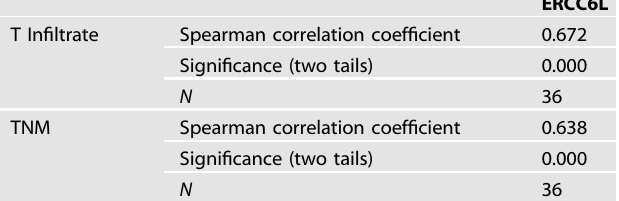
Table 3. Relationship between ERCC6L expression and tumor characteristics in patients with